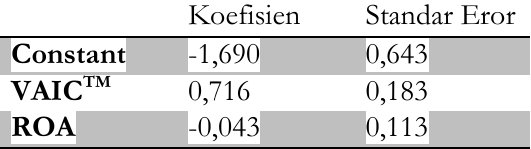
Table 6. Intellectual Capital_IC Regression Tests and Financial Performance of Company Values